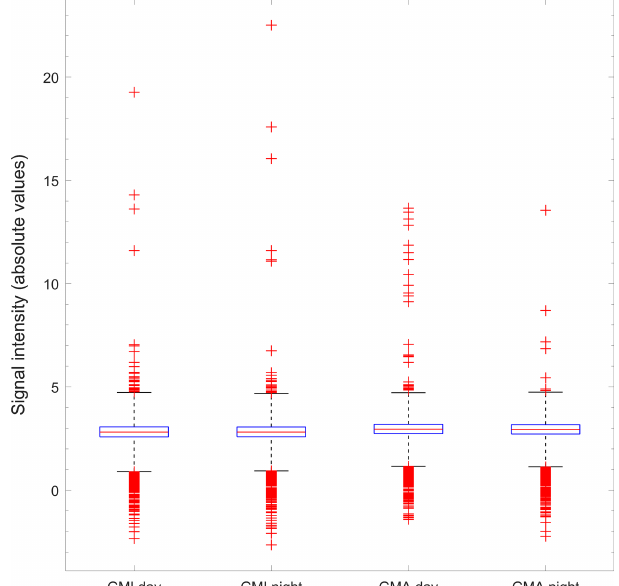
Figure 3. Distribution of normalized GMI and GMA extrema in ab- solute values calculated from 43000 granules (21500 for daytime conditions and 21500 for nighttime conditions). The lower and up- per limit of the blue box represents the 25th percentile and the 75th percentile in the data. The red line represents the median. The black lines represent the upper adjacent value (UAV) and lower adjacent value (LAV), and the red crosses are considered to be outliers in the dataset. The dashed magenta line represents the F 1